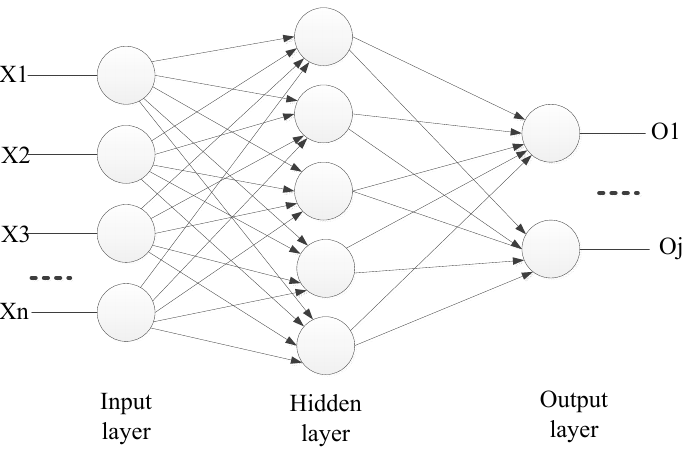
Figure 7. Artificial neural networks (ANN) model.